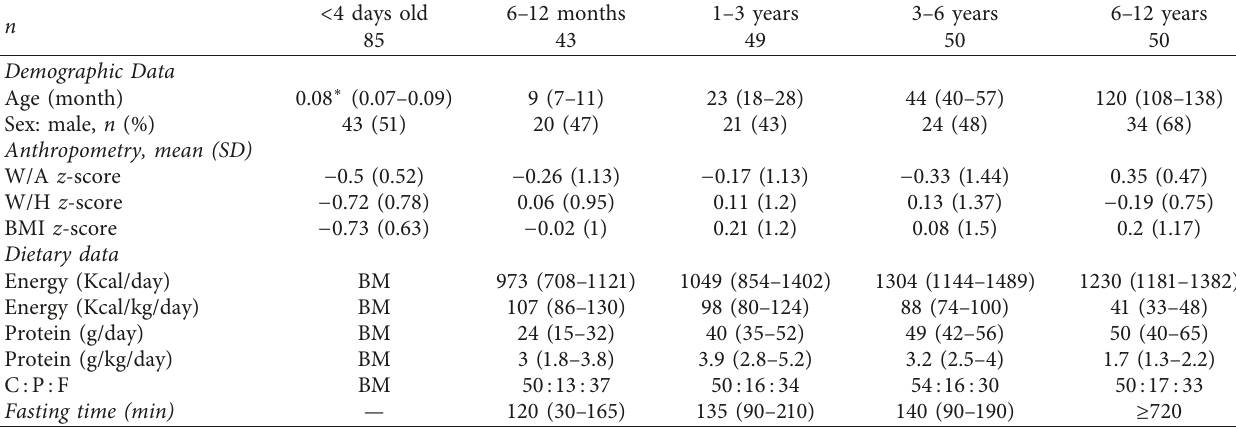
Table 2: Characteristics of 277 subjects regarding demographic data, anthropometry, and dietary intake (BM � breast milk predominant; C � carbohydrate; P � protein; F � fat).